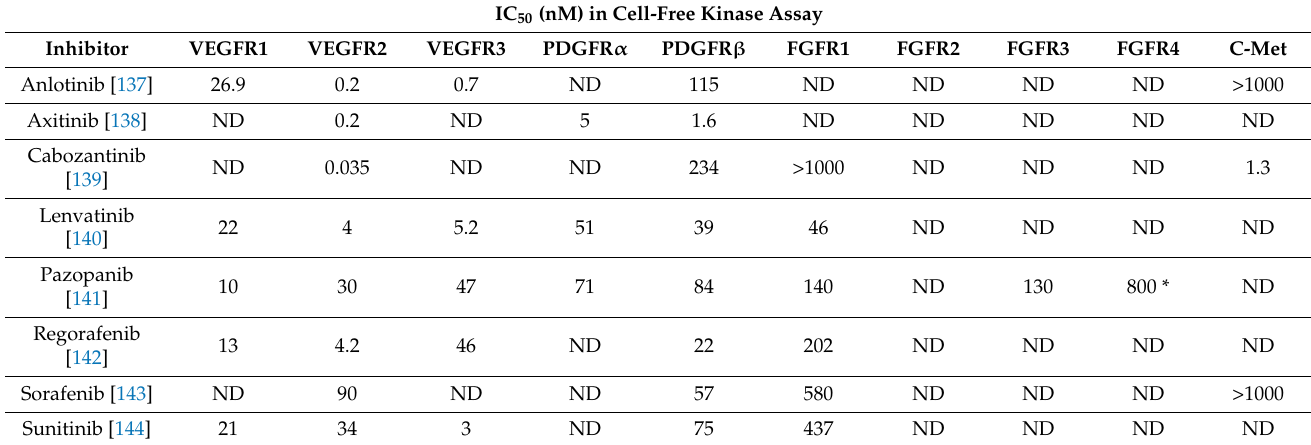
Table 5. Comparative inhibitory effect of some tyrosine kinase inhibitors. IC 50 (nM) in Cell-Free Kinase